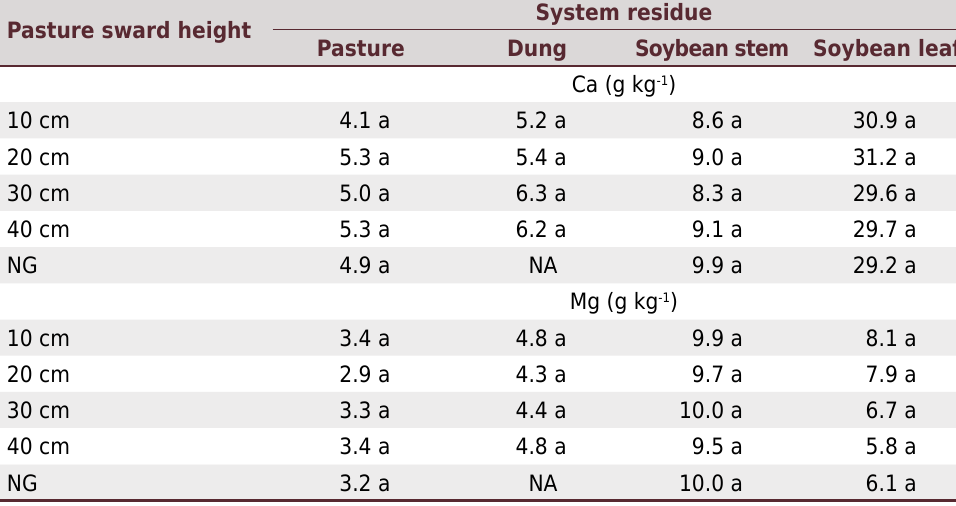
Table 1. Calcium and magnesium concentrations from pasture, dung, and soybean residues in an integrated soybean-beef cattle system under no-till with varying grazing intensity (i.e. sward height managed by grazing) (São Miguel das Missões, RS, Brazil) System residue Pasture sward height Pasture Dung Soybean stem Soybean leaf Ca (g kg -1